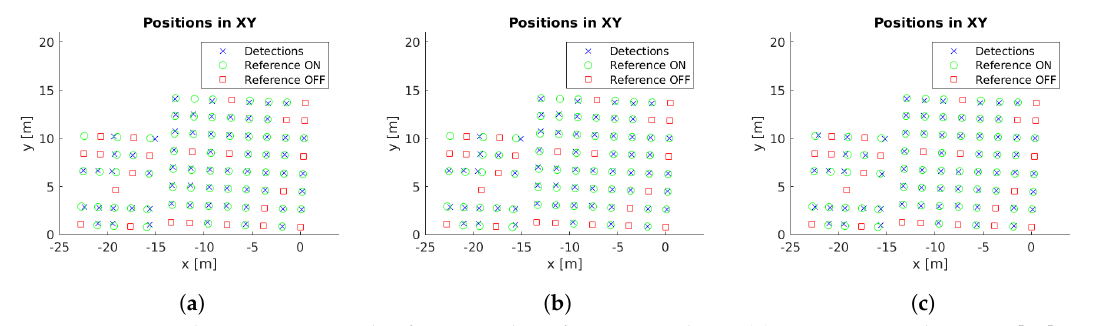
Figure 10. Cluster centers and reference values for case study 5. ( a ) Unconstrained system [31], ( b ) system with reprojection error filtering, and ( c ) system with filtering and orientation